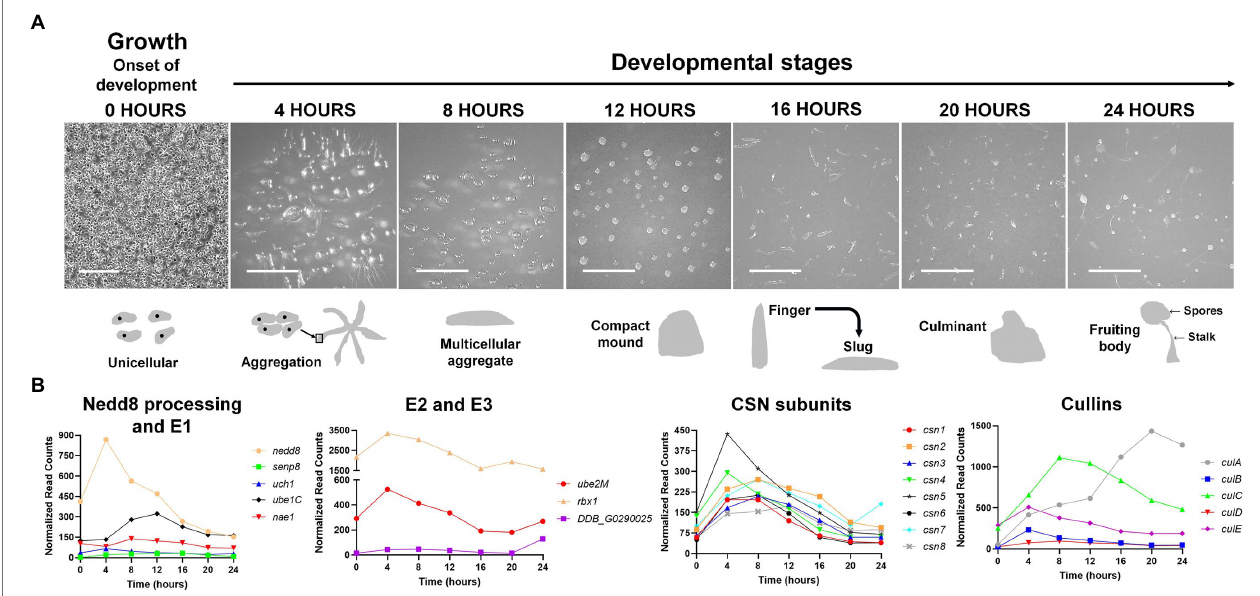
FIGURE 3 | (A) The Dictyostelium discoideum life cycle. The asexual life cycle of D. discoideum occurs within 24 h. D. discoideum cells are unicellular during growth and divide by mitosis. Starvation triggers the onset of development. Starved amoebae undergo cyclic adenosine monophosphate (cAMP)-mediated chemotactic aggregation to form a multicellular aggregate, followed by compact mound, which then undergoes a series of morphological changes to form a finger that falls on the surface to generate a motile slug. Cells within the slug then terminally differentiate during culmination to form a fruiting body composed of a mass of viable spores that sit atop a slender stalk. In the laboratory, the multicellular developmental program is induced by depositing cells on non-nutrient agar plates. Scale bar (0 h) = 200 μ m. Scale bar (4–24 h) = 2 mm. Images are not drawn to scale. (B) Expression profiles of cullin genes, genes encoding CSN subunits, and genes involved in Nedd8 processing, activation, and conjugation during the D. discoideum life cycle. Transcript data were derived from RNA-Seq data obtained from dictyExpress (http://www.dictyexpress.biolab.si) and replotted using GraphPad Prism 8. Expression profiles were examined for genes that encode proteins involved in Nedd8 processing ( nedd8 , senp8 , and uch1 ), E1 ( nae1 and ube1C ), E2 ( ube2M ), E3 ( rbx1 , DDB_G0290025 ), and the COP9 signalosome ( csn1-8 ). Expression profiles for genes that encode cullins ( culA - culE ) are also shown. csn, COP9 signalosome; cul, cullin; nae1, Nedd8-activating enzyme E1 subunit 1; nedd8, neural precursor cell expressed developmentally downregulated protein 8; rbx1, ring box 1/regulator of cullins 1; senp8, sentrin-specific protease 8; ube, ubiquitin- activating enzyme; and uch, ubiquitin C-terminal